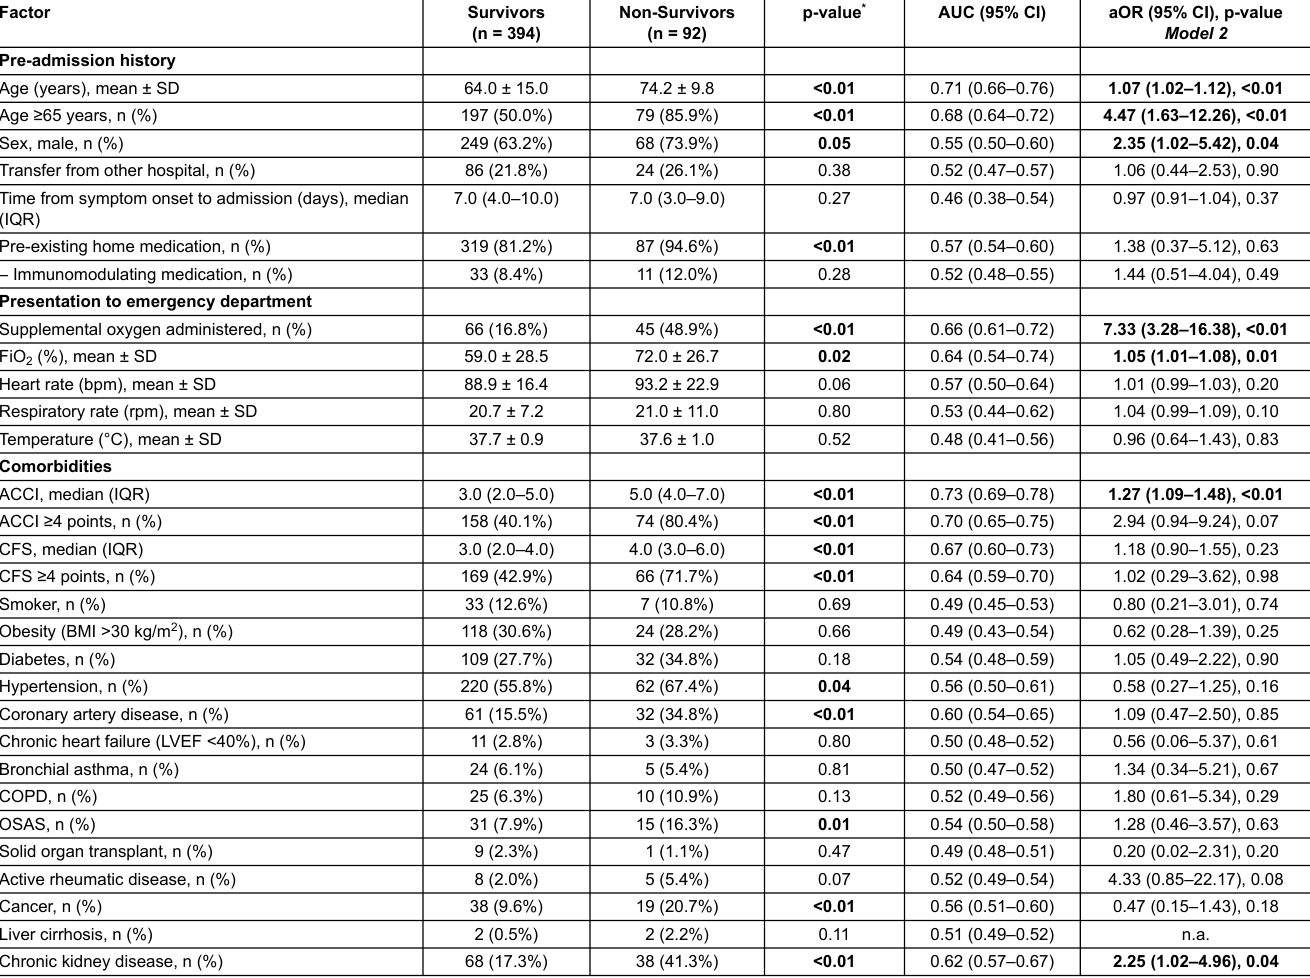
Table 3: Association of baseline characteristics and vital signs upon admission stratified by all-cause in-hospital mortality.